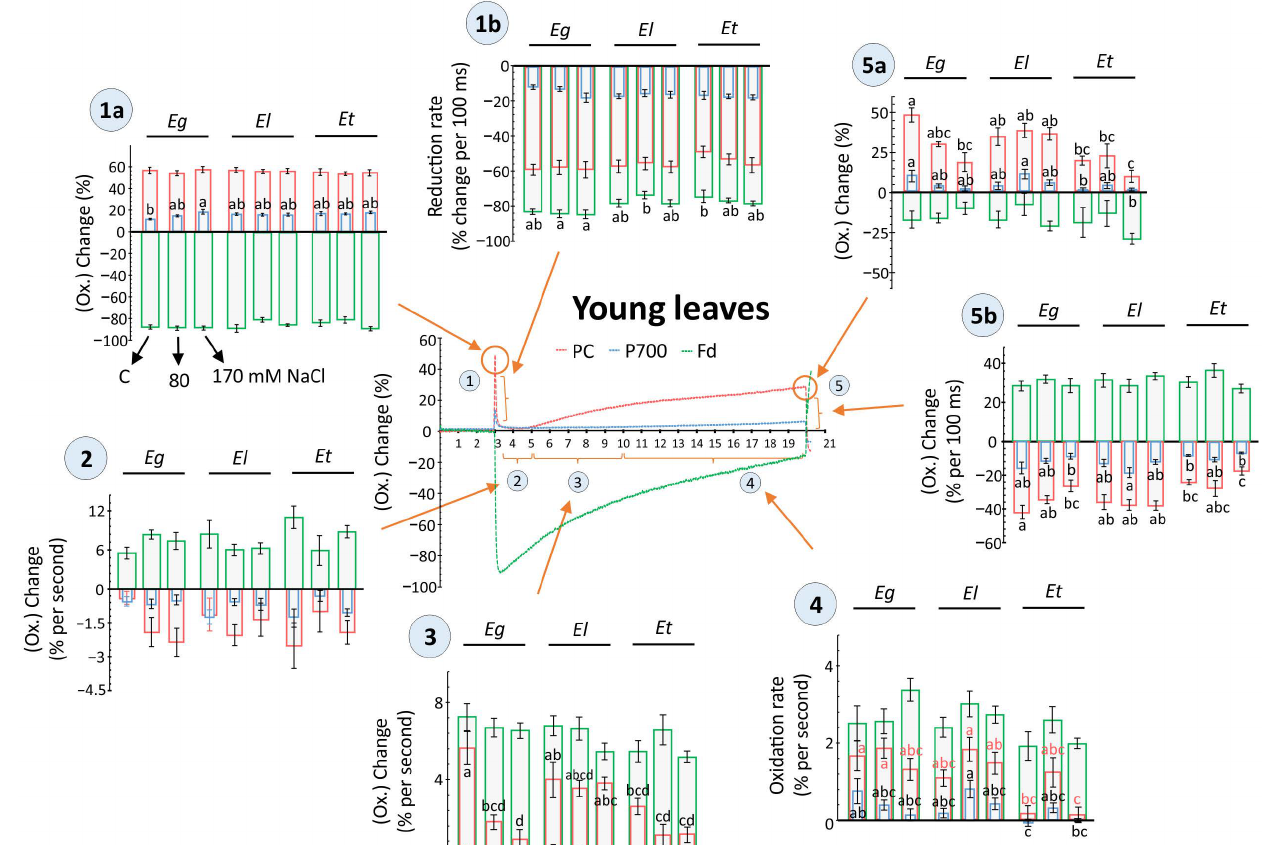
Figure 5. Light-driven redox changes for PC, P700 and Fd as recorded in young leaves of Eucalyptus spp under salt stress. Dark-adapted, detached young leaves of 30 d salt treated Eucalyptus spp were exposed to 160 µ mol m − 2 s − 1 for 17 s and redox states of plastocyanins (PC), photosystem I (PSI) and ferredoxin (Fd) were recorded along with chlorophyll a fluorescence (Figure 4) using the DUAL-KLAS-NIR (Walz, Germany). The scatter plots depict representative kinetics of light-driven redox change at five different phases, as indicated i.e., 1(a, b), 2, 3, 4, 5 (a, b), based on light-dependent temporal shifts in the redox state of PC, PSI, and Fd (Phase 1 = Dark to light shift, Phase 2, 3 = dynamics of reoxidation, Phase 4 = apparent steady state, Phase 5 = end of light phase and light to dark shift. In phase 1 and 5, ‘a’ = max. value, ‘b’ = rate of redox shift). For individual phases, the redox changes were compared among plant species and different salt treatments and shown as histograms in form of the maximal changes or rates of redox transition (means ± SE, n = 9–12, p < 0.05; ANOVA and Tukey’s post-hoc